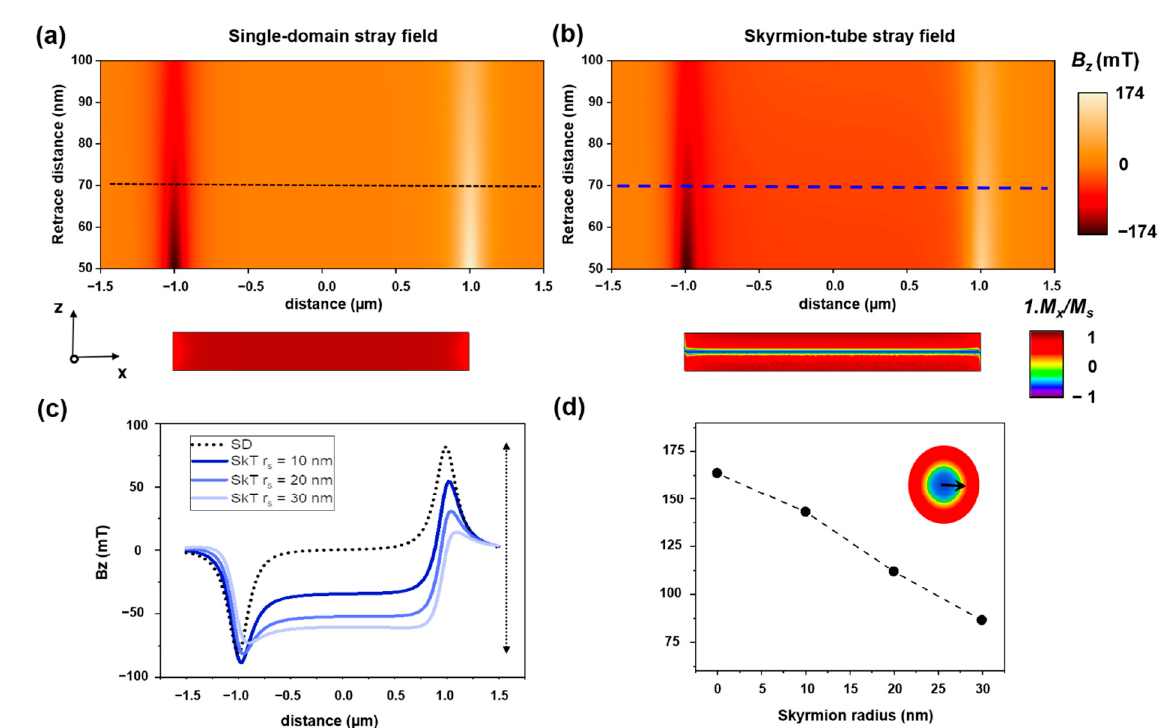
Figure 3. Simulated stray field map between 50 and 100 nm from the nanowire for a ( a ) single domain and ( b ) a skyrmion- tube configuration in a magnetic nanowire, for a skyrmion radius r s = 20 nm. ( c ) Corresponding stray field contrast profiles at 70 nm of the nanowire surface. ( d ) Dependency of the stray field “contrast” on the skyrmion radius, defined in the inset. The line is drawn as a guide to the eyes.